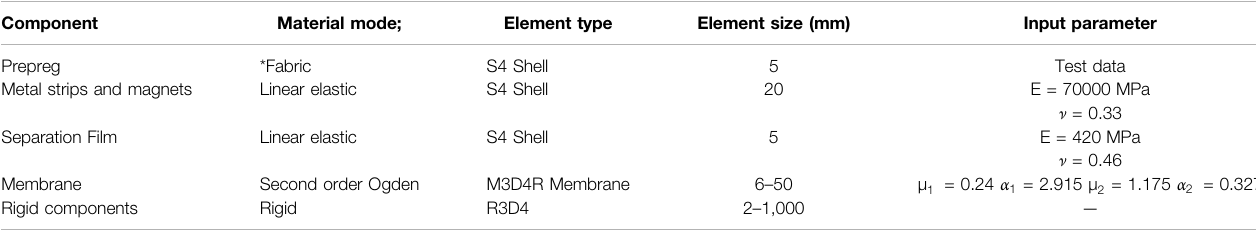
TABLE 1 | Model speci fi cations.